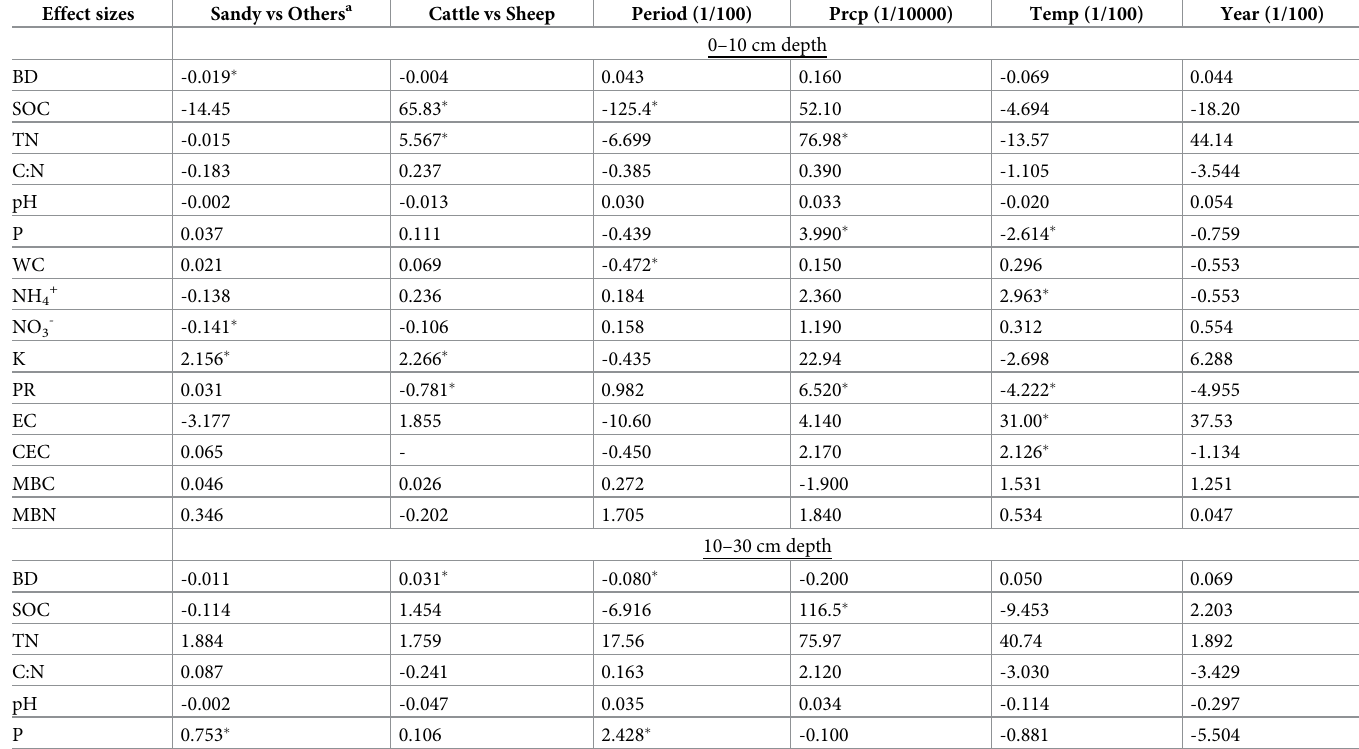
Table 1. The coefficients of the soil texture (Sandy vs others), animal (Cattle vs. sheep), grazing period (Period), precipitation (Prcp), temperature (Temp), and sampling year (Year) in the 21 mixed models for the 0–10 and 10–30 cm depths. The complete covariate coefficients are presented in S2 Table. Effect